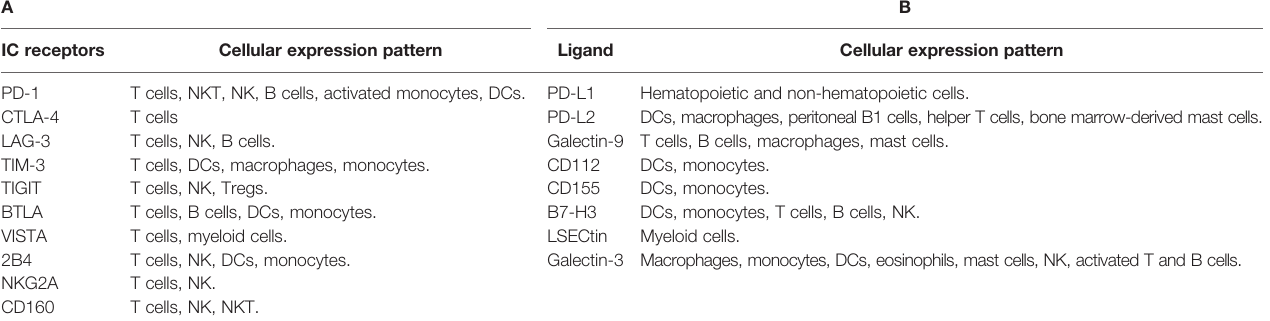
TABLE 1 | Summary of immune checkpoint receptors (A) and ligands (B) covered in this review. A B IC receptors